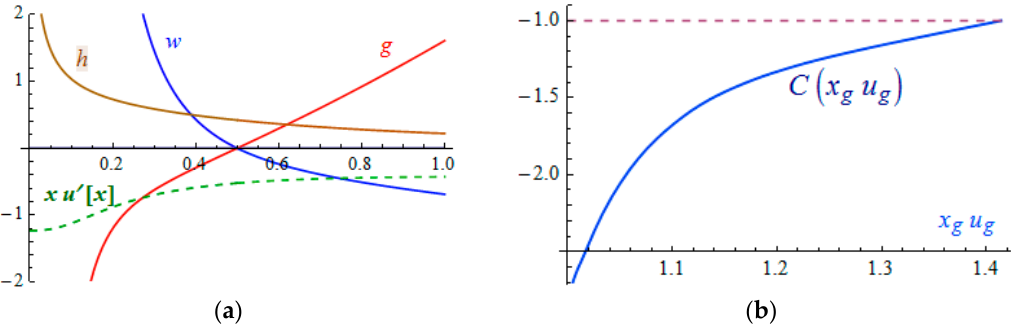
′× (cid:48) ( x ) ( a ). Dependence C ( x ( a ). Dependence )( gg uxC (Equation (37)) ( b ). Figure 6. Dashed green line is x × u